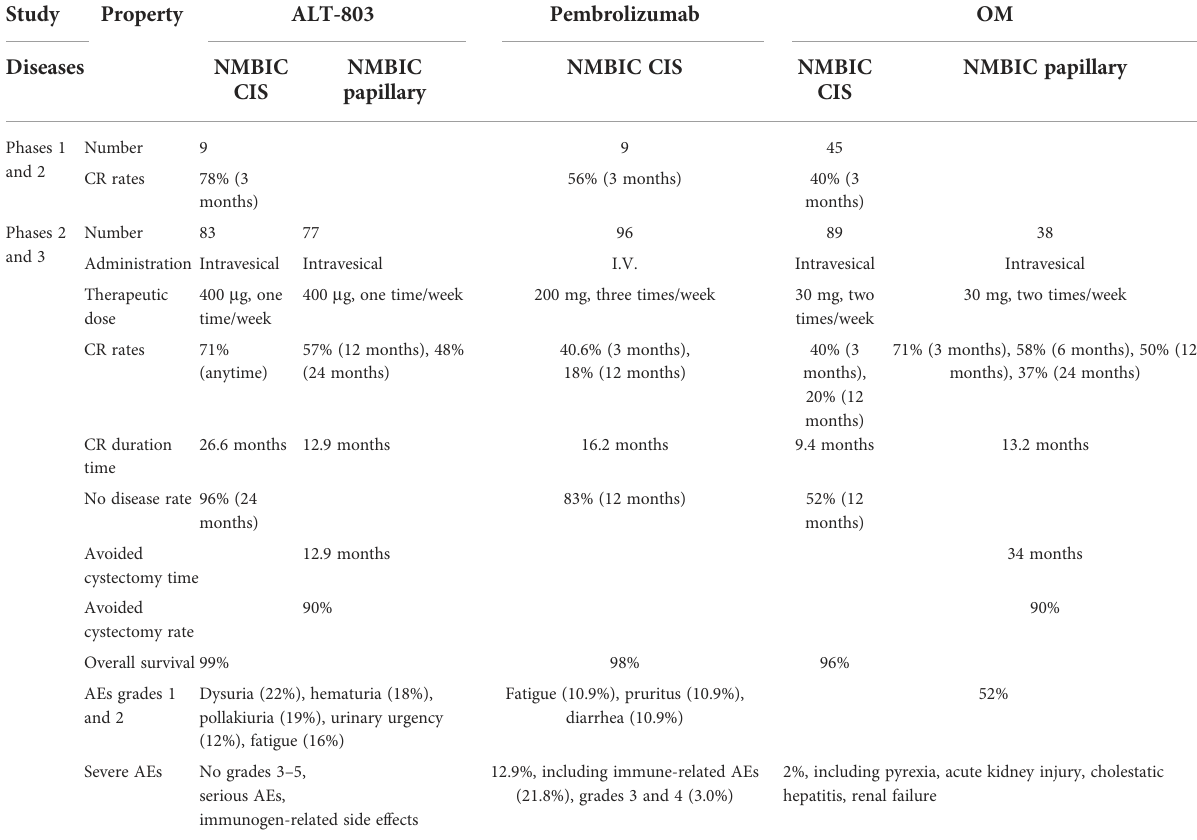
TABLE 2 Phases 1 – 3 clinical comparison of ALT-803, pembrolizumab, and oportuzumab monatox (OM) for the treatment of Bacillus Calmette – Gue ́ rin-unresponsive